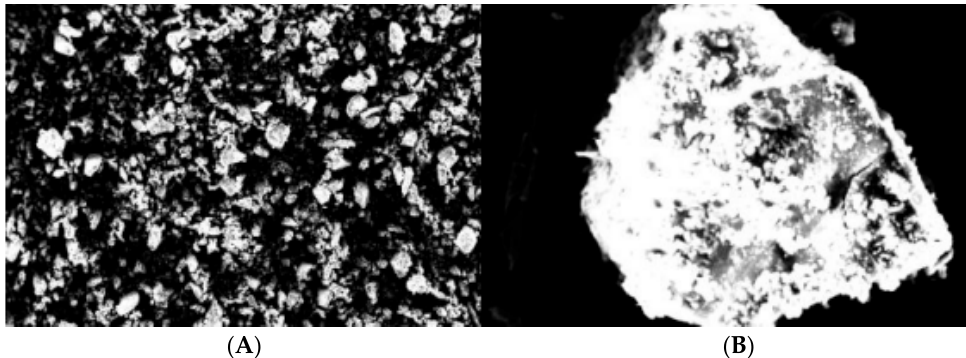
Figure 5. SEM images of ketoconazole inclusion complexes (×100, A ), (×500, B ).